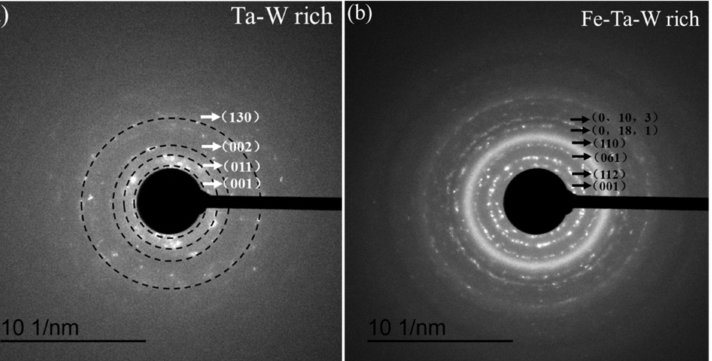
Figure 8. ( a ) The selected area electron diffraction (SAED) pattern of the Ta-W rich layer in the ST3 sample; ( b ) SAED patterns of the Fe-Ta-W rich layer in the HT3